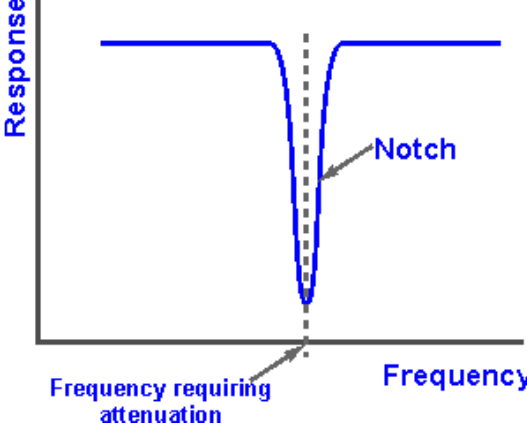
Fig 2 . Amplitude response of a notch